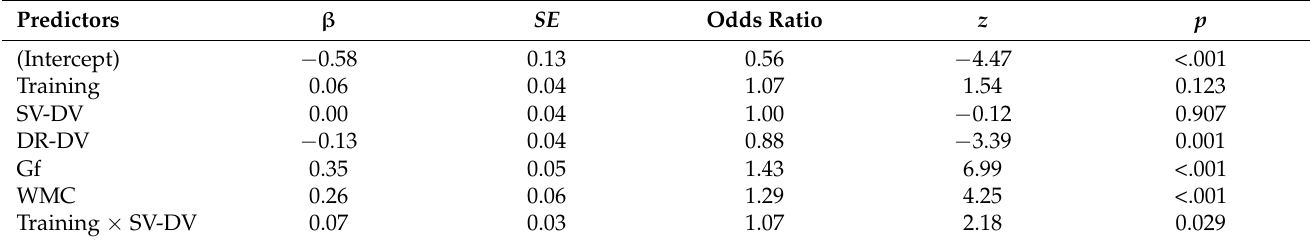
Table 9. Predicting figural analogy accuracy with same version–different version and different rule–different version measures and